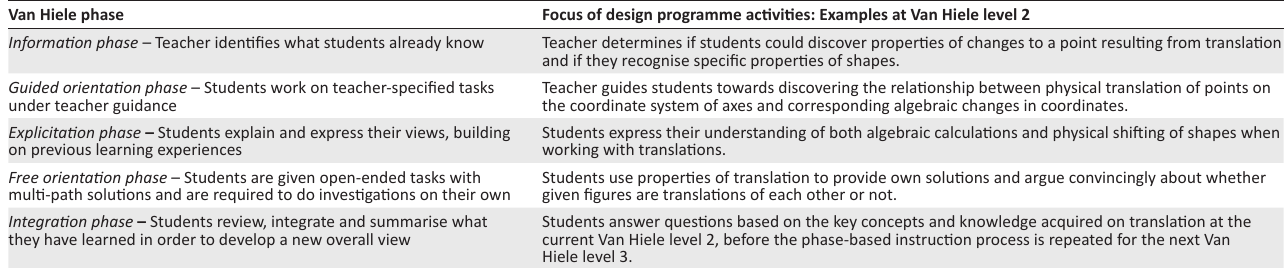
TABLE 4: Overview of the Van Hiele phase-based programme design. Van Hiele